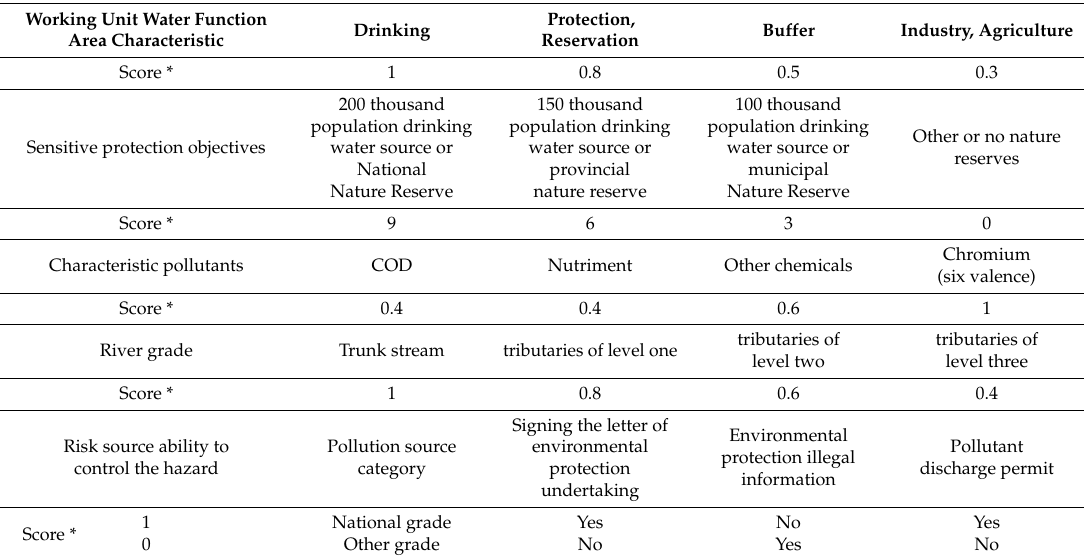
Table 3. Statistical table of risk sources risk